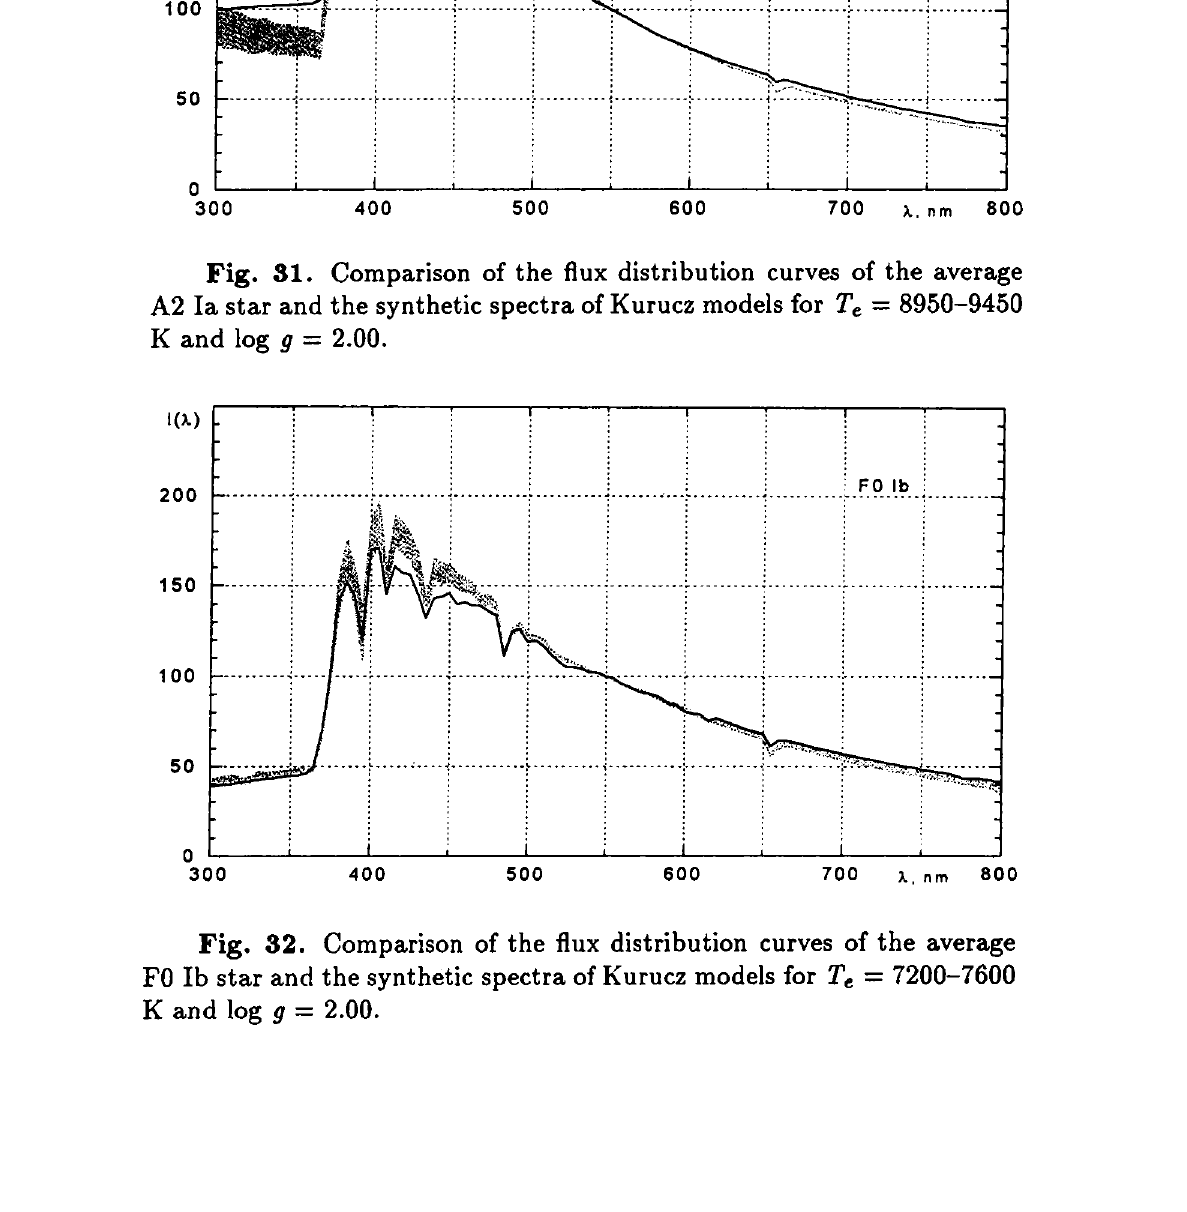
Fig. 32. Comparison of the flux distribution curves of the average F0 lb star and the synthetic spectra of Kurucz models for T K and log g =